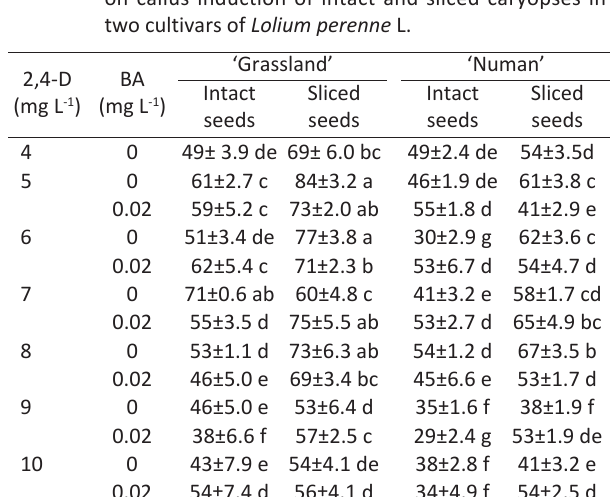
Values represent mean ± SE. Means with the same letter are not significantly different at p ≤ 0.05.